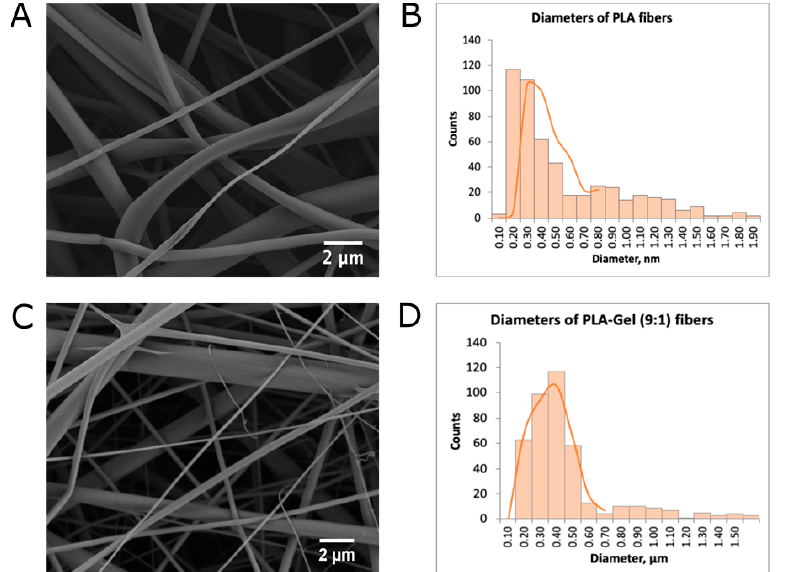
Figure 1. SEM analysis of electrospun mat morphology. ( A ) SEM image of an electrospun PLA mat. ( B ) Fiber diameter distribution obtained from the SEM image analysis of PLA mats. ( C ) SEM image of an electrospun PLA–gelatin (9:1) mat. ( D ) Fiber diameter distribution obtained from the SEM image analysis of PLA–gelatin (9:1) mats.